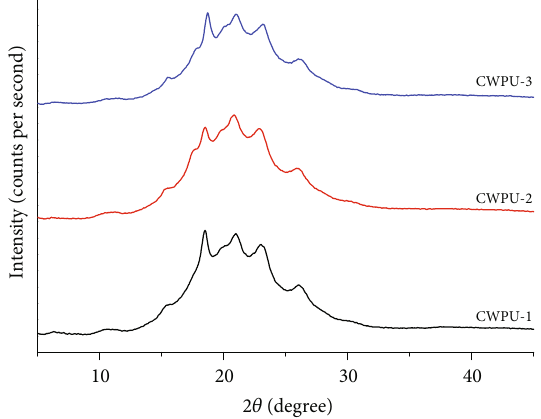
Figure 7: DSC thermograms of cationic waterborne polyurethanes (CWPUs) with various internal emulsi fi er